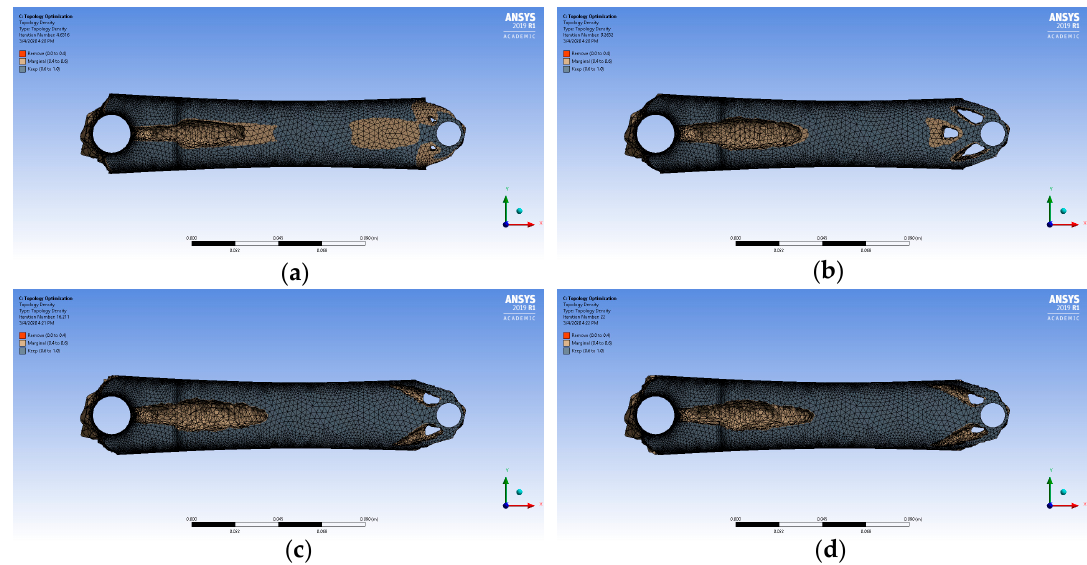
Figure 7. The topology optimization history: ( a ) 5th iteration, ( b ) 10th iteration, ( c ) 16th iteration, ( d ) 22nd iteration.